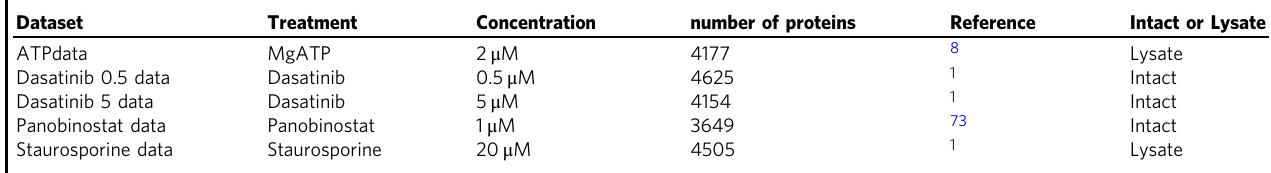
Table 1 Summary of the datasets and the respective reference used in this manuscript. Dataset